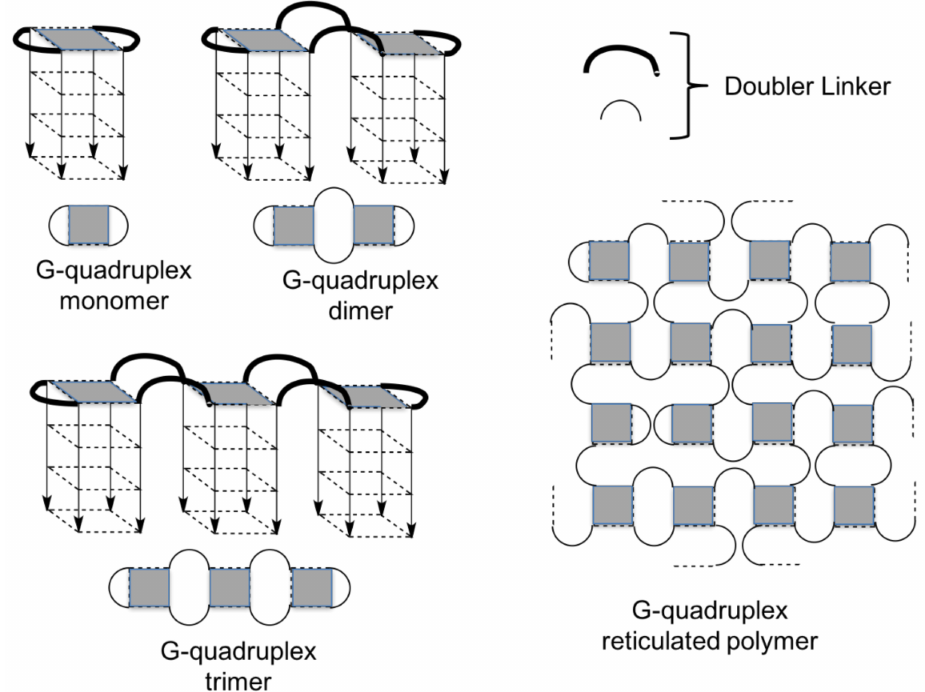
Figure 4. Schematic representation of the parallel G4s obtainable from the self-assembly of DEL-ODNs. The first three complexes, having the least MW, are shown on the left. The hypothetical topology of G4 supramolecular nanostructures based on reticulated parallel DEL-G4s is shown on the right. The t R of all peaks corresponding to TEL-G4 monomers (Q 1 ), obtained by performing the HPLC–SEC separation of the annealed TEL-ODNs (Figure 3, right column), were